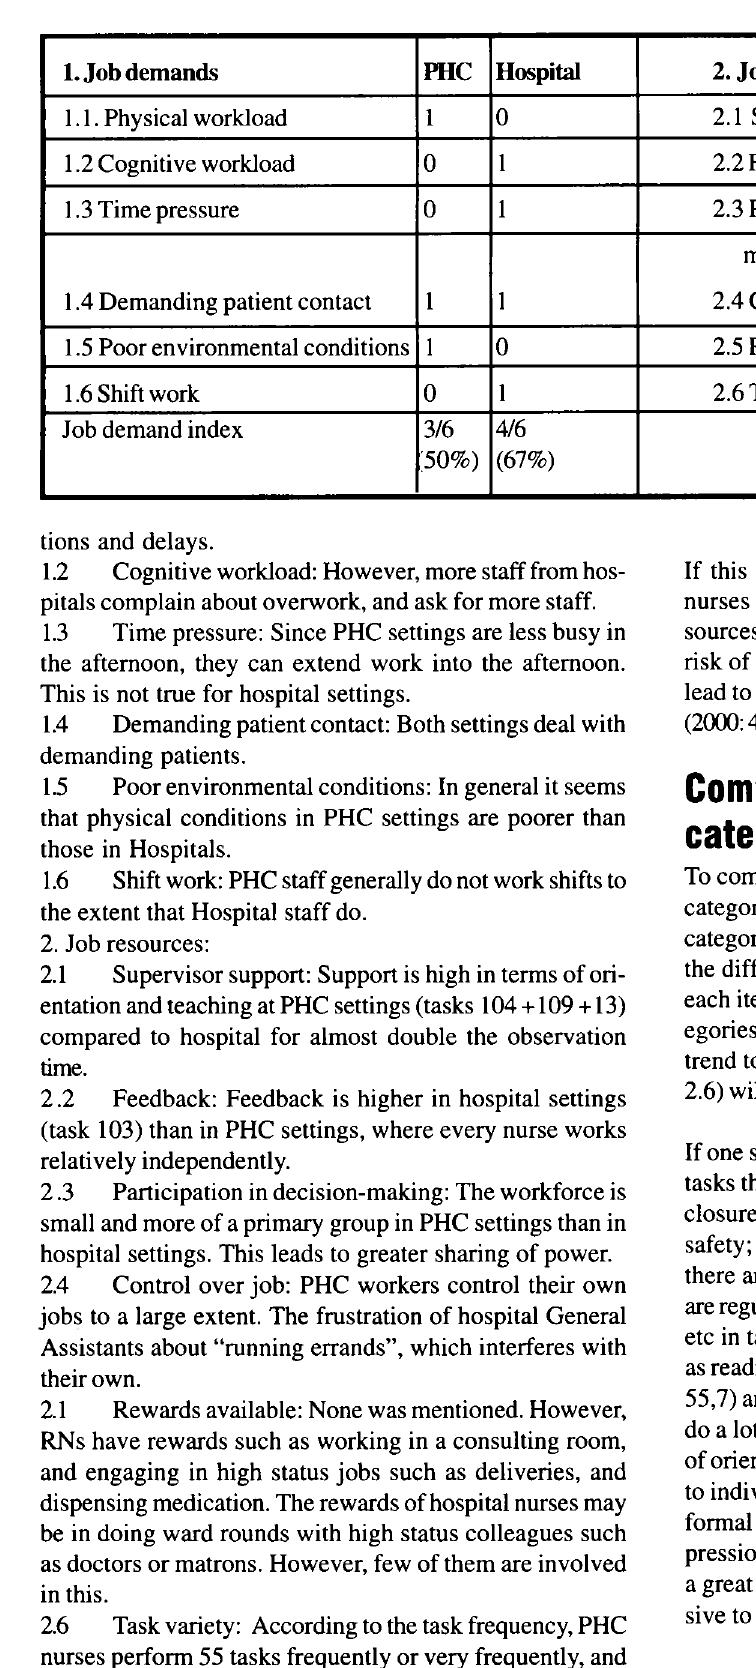
Table 2.5 Comparison of settings in terms of Exhaustion-Disengagement